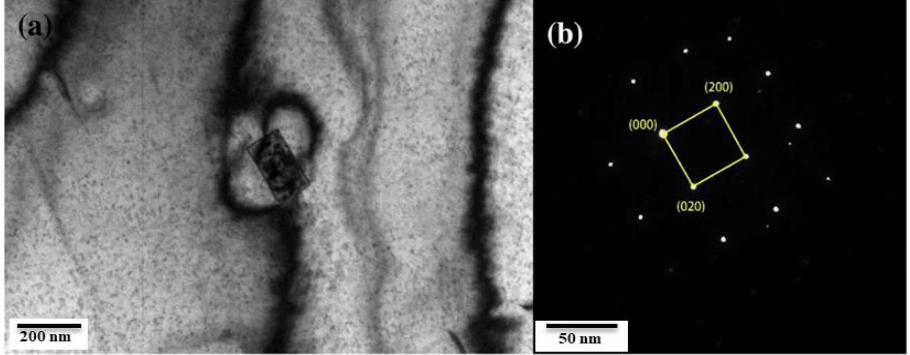
Figure 6. ( a ) TEM morphology of the precipitated phase; ( b ) SAED mode of the precipitated phase [66]. Reproduced with permission of Elsevier, copyright